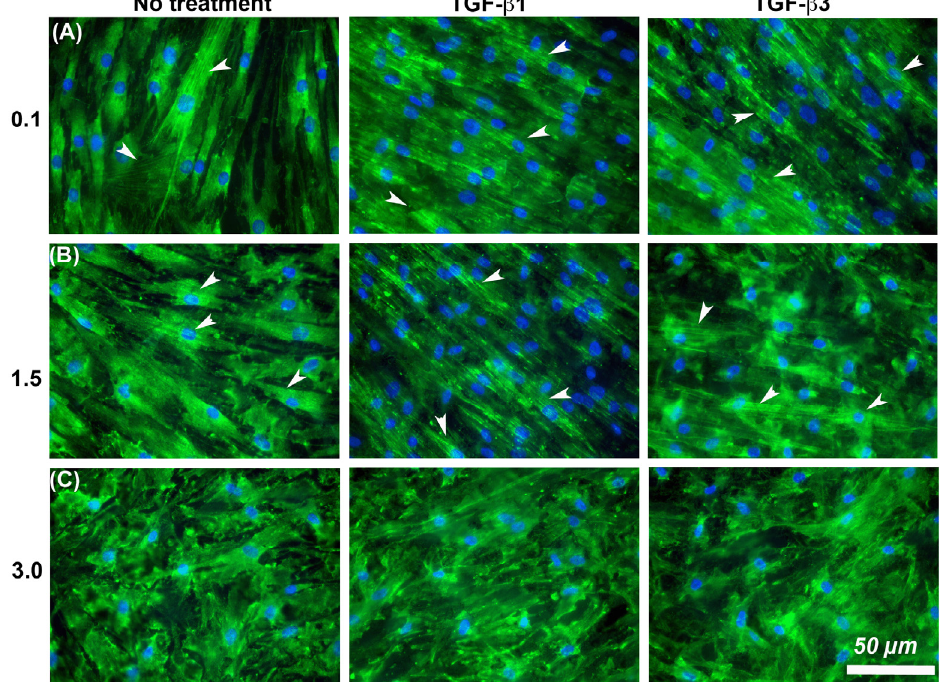
Figure 8. Influence of TGF- β isoforms and substratum roughness on α -SMA stress fiber formation in HGFs. ( A ) Stimulation of HGFs on R a = 0.1 for 7 days with TGF- β 1 and TGF- β 3 increased α -SMA incorporation into stress fibers in comparison with untreated controls. ( B ) On surfaces of R a = 1.5, both exogenous TGF- β 1 and TGF- β 3 increased myofibroblast differentiation versus controls, ( C ) but this was inhibited on R a = 3.0. White arrows indicate fully differentiated myofibroblasts.